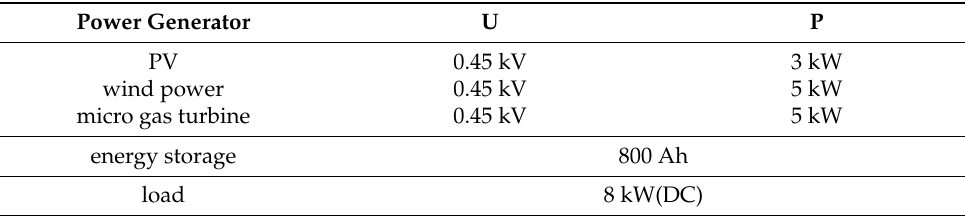
Figure 2. Architecture of the DC microgrids. Table 1. Main parameters of the microgrids